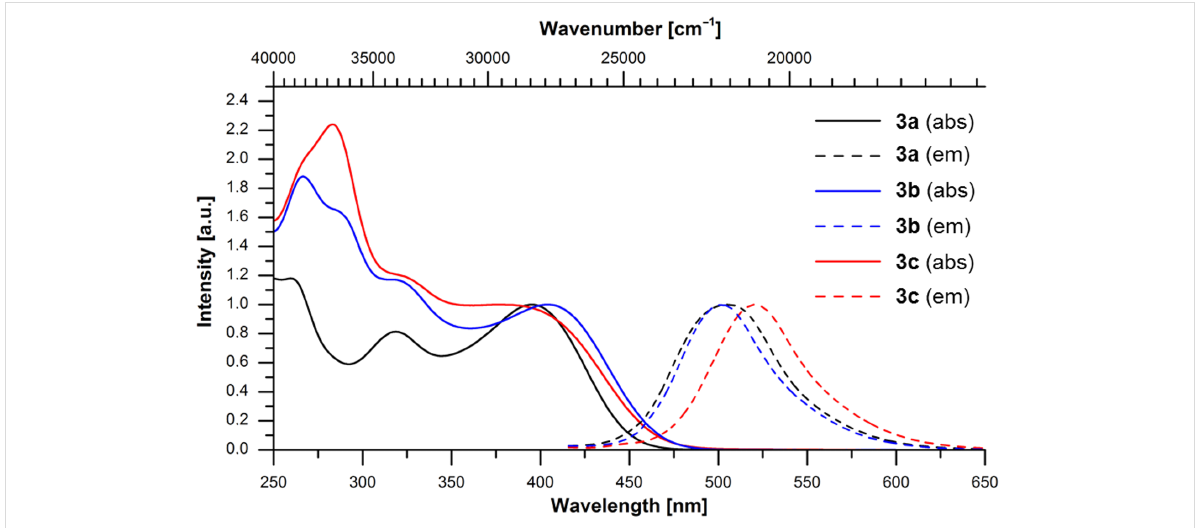
Figure 3: UV–vis (solid lines) and fluorescence spectra (dashed lines) of the thienyl-bridged oligophenothiazines 3 (recorded in CH 2 Cl 2 , T = 298 K).